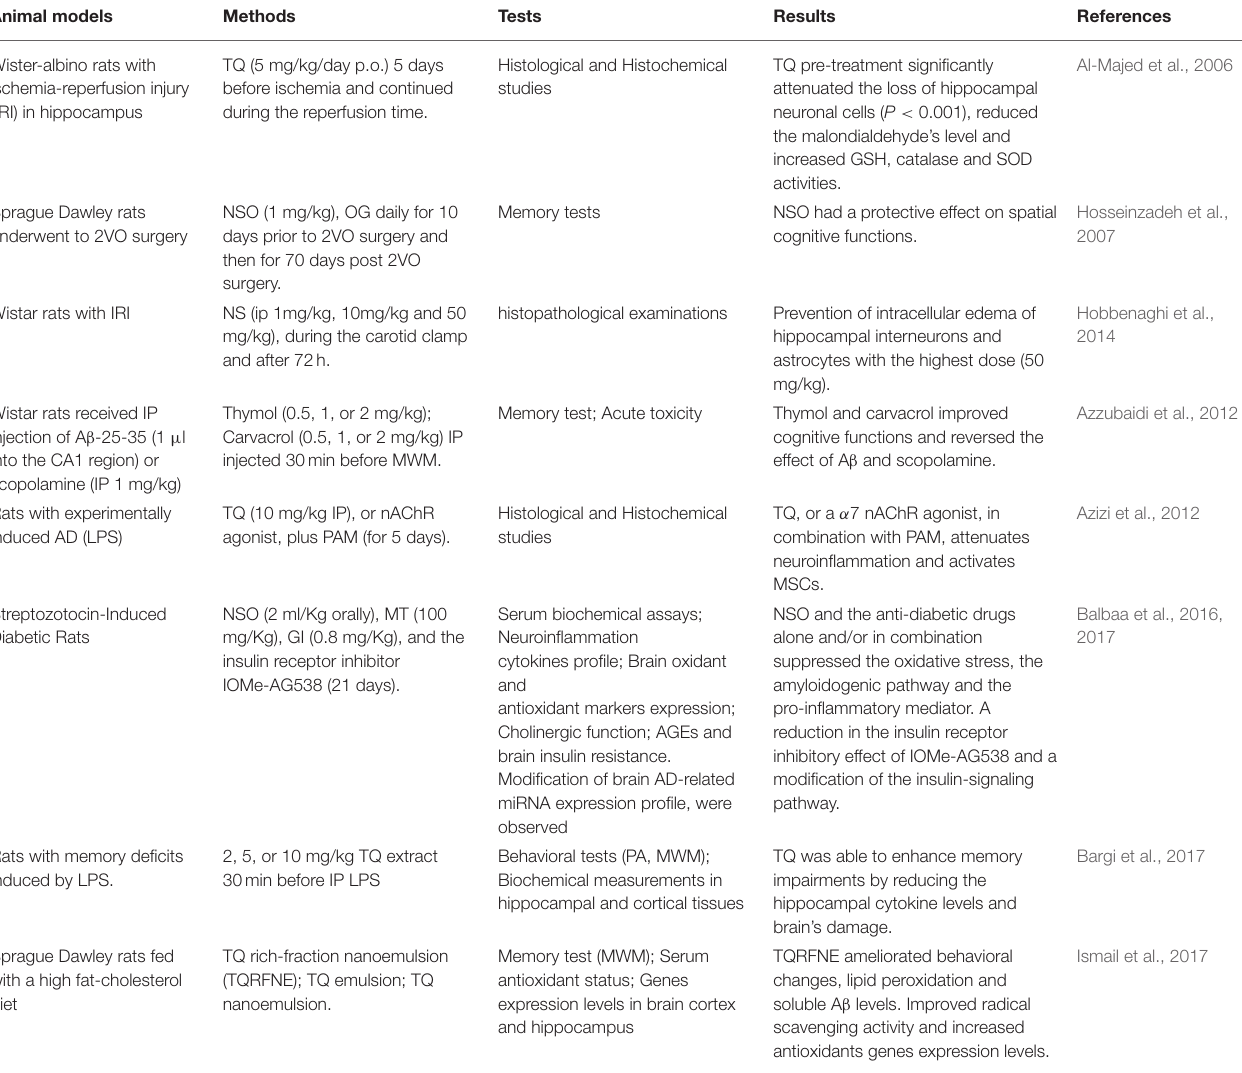
TABLE 2 | In vivo experiments on the anti-neurodegenerative properties of NS or TQ in AD. Animal